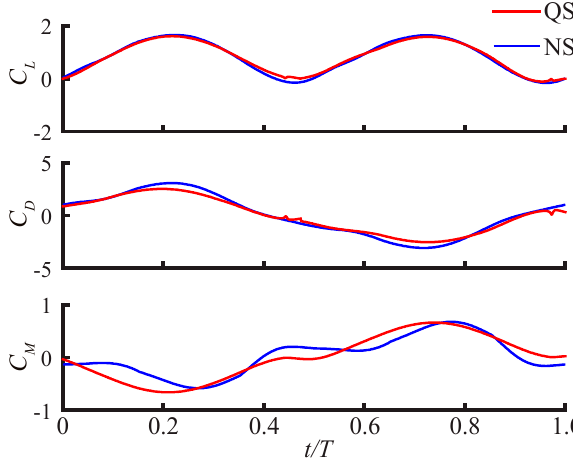
Figure 16. Plots of coefficients of lift ( top ), drag ( middle ), and moment ( bottom ) over one period for QS (red) and NSe (blue) predictions for the small difference motion. In the figure the cycle-averaged lift coefficient for the QS is 0.83 and the NSe is 0.82. A = 30°, Δ τ r = 0.3, and x pa = 0.5.